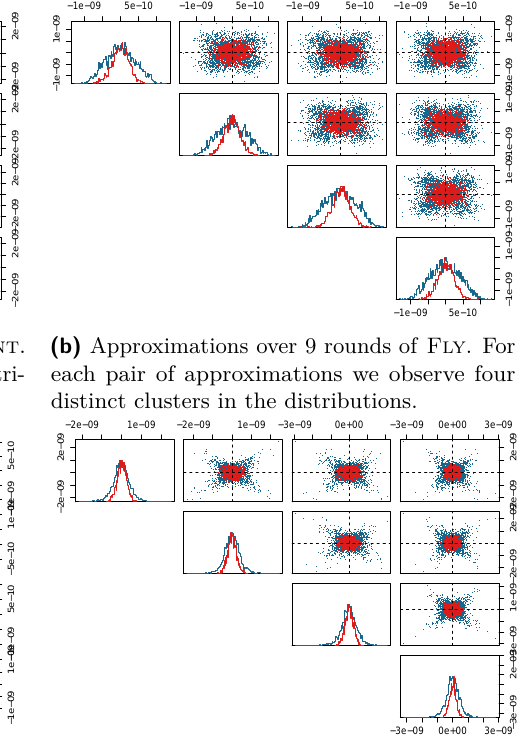
(c) Approximations over 12 rounds of GIFT-64 . ANGLE. For each pair of approximations we observe a significant deviation from normality, manifested by very long tails of the distribu- tions. Figure 6: Shown in blue, the pairwise joint linear correlation distributions for four linear approximations. The correlation distribution of an ideal cipher is shown in